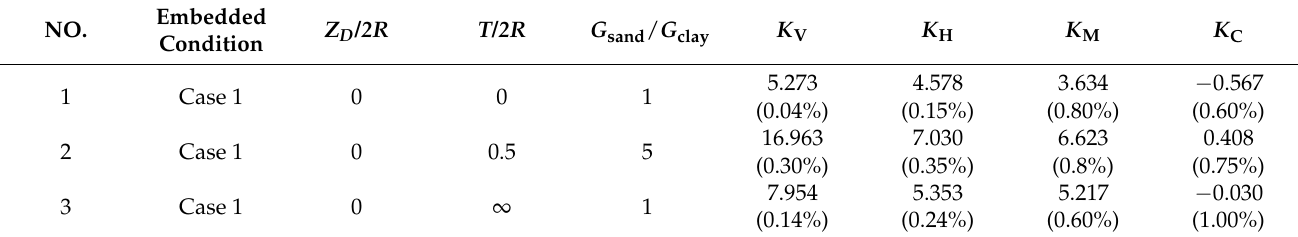
Table 3. Comparison of the elastic coefficients between this study and